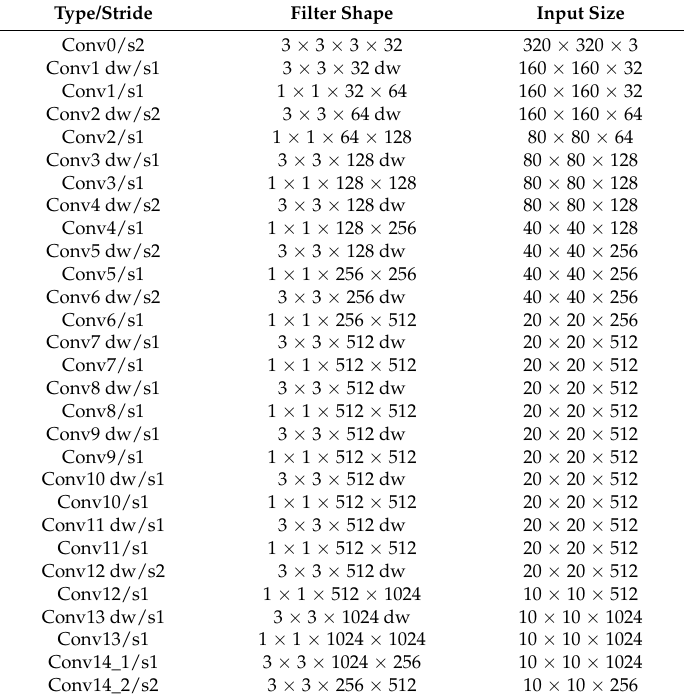
Table 1. The body architecture of the base